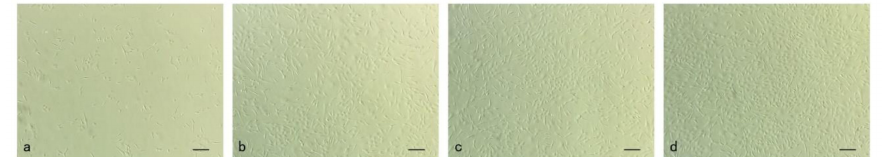
Figure 1. Micrographs of Japanese flounder muscle cells in primary culture; bar = 100 µ m. ( a ) 1 day after seeding, sticking to the wall and extension of muscle cells were observed; ( b ) 3 day after seeding, completely stretching and proliferation were observed; ( c ) 4 day after seeding, the cells reached a fusion rate of 80–90%; ( d ) 5 day after seeding, the cells overspread the culture bottle